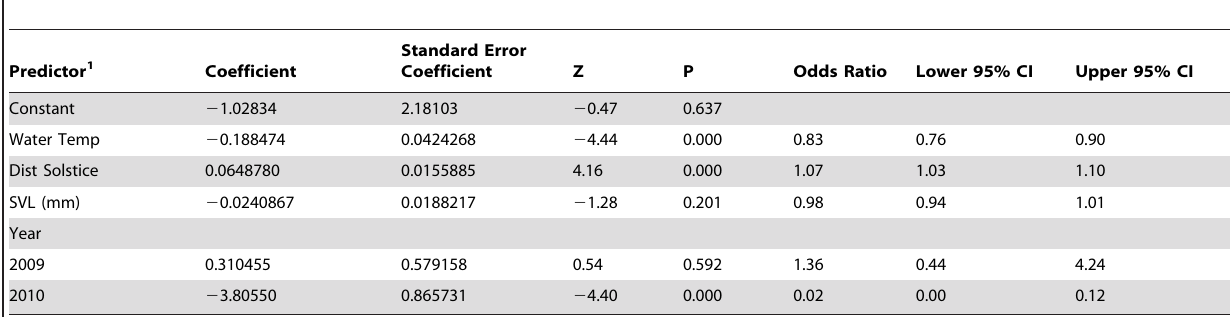
Table 2. Logistic binary regression of infection status (0 =not infected; 1=infected with Batrachochytrium dendrobatidis ) of lowland leopard frogs Rana ( Lithobates ) yavapaiensis (N= 198; 3 missing